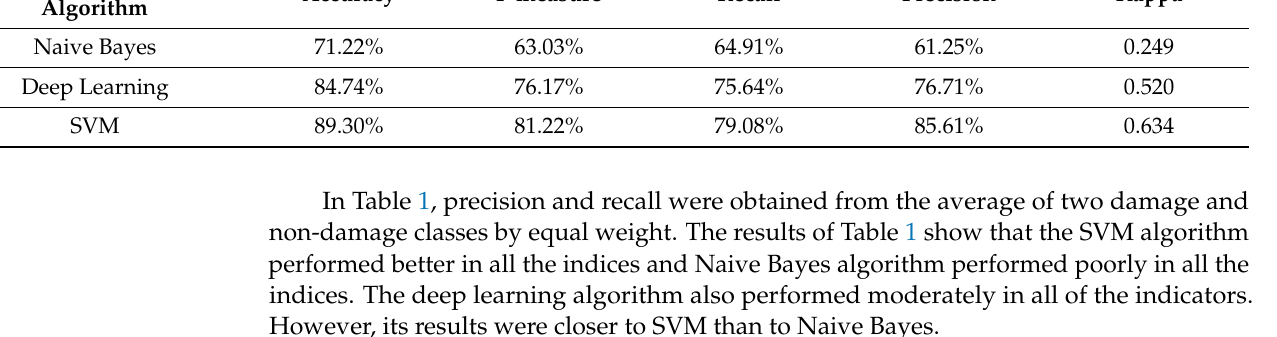
Table 1. Performance of Naive Bayes, SVM, and deep learning binary classification. Binary Classification Algorithm